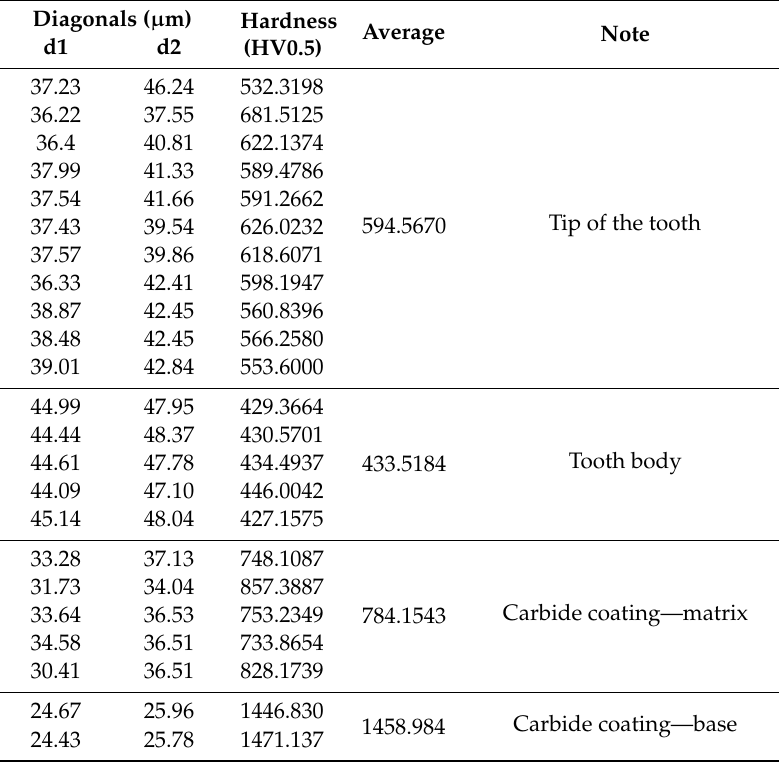
Figure 14. Vickers hardness test on the tip of the tooth. Table 11. Vickers hardness test